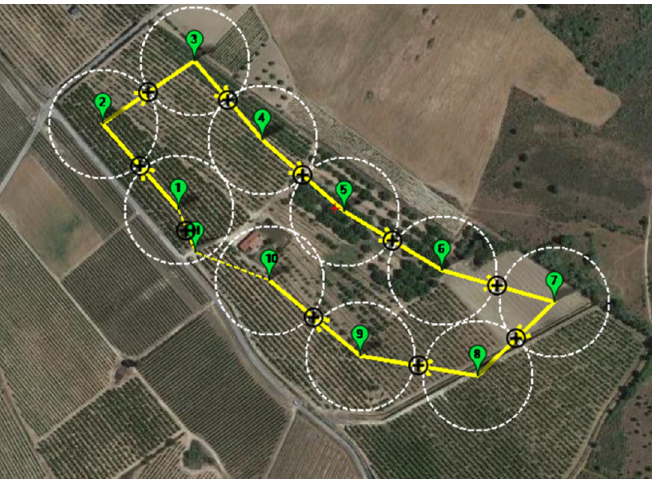
Figure 9. PoIs of the Case Study #2. Table 6. Incidence rate vectors for Case Study #2.